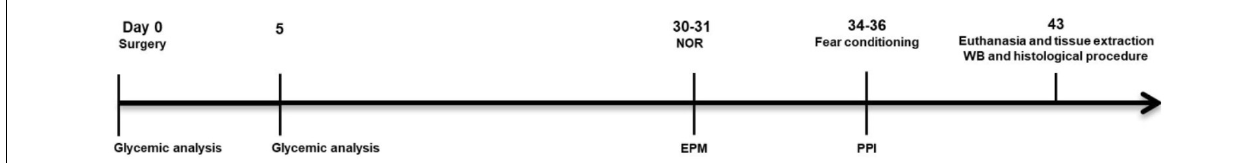
FIGURE 1 | Timeline of the experimental design. Thirty days after receiving AEA (100 ng) and/or STZ (2 mg/kg), rats were submitted to behavioral tasks to detect early deficits of emotional and non-emotional memories and sensorimotor gating. One week after the end of behavioral tasks, the animals were sacrificed for either neurochemical analysis of their hippocampi by Western Blotting (WB) or histological analyses of their brains.